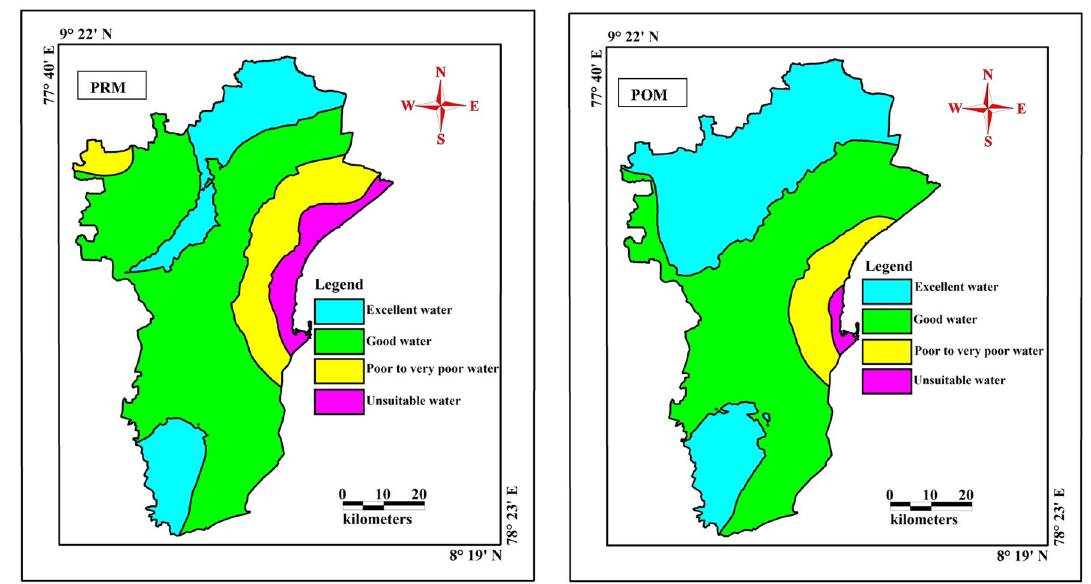
Fig. 4 Spatial distribution of WQI in the study area during PRM and